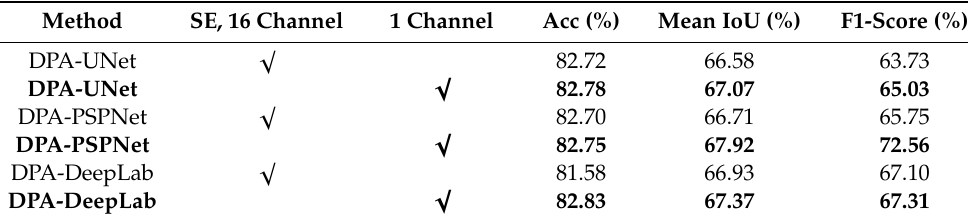
Table 5. DPA-Net performance using the structure in Figure